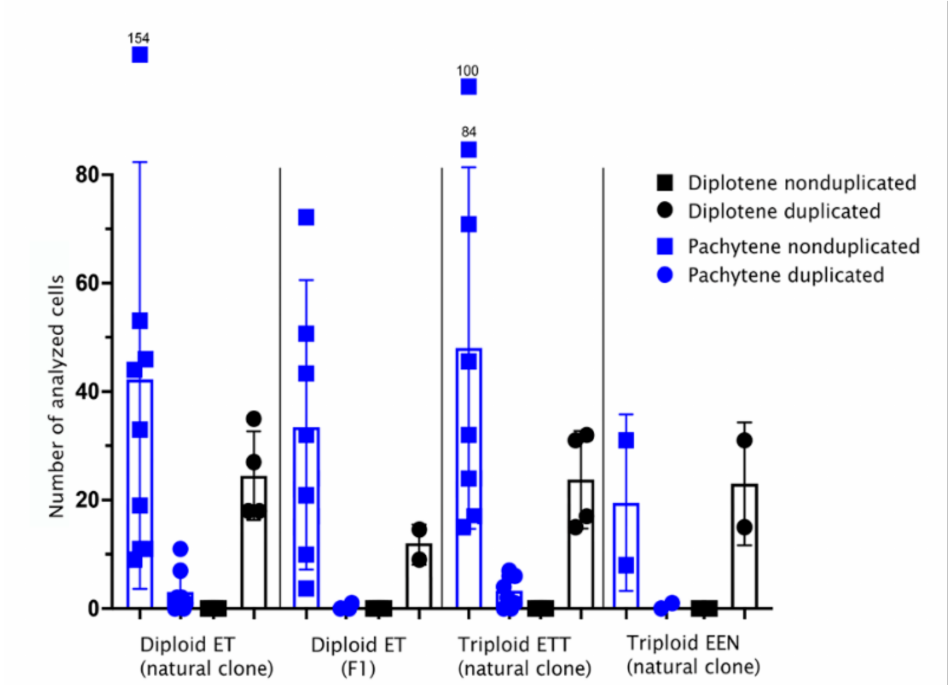
Figure 2. The number of cells with duplicated (marked as circles) and nonduplicated (marked as squares) genomes observed during pachytene and diplotene in natural diploid ET hybrids, artificial F1 diploid hybrids, and natural triploid ETT and EEN hybrids. The number of cells: mean ± standard deviation. During the pachytene stage (blue graphs), two populations of oocytes were detected in all diploid and triploid hybrid individuals. The major population of oocytes did not have a duplicated genome (oocytes with diploid and triploid genomes for diploid and triploid hybrids, correspondingly) and the minor population had a duplicated genome (oocytes with tetraploid and hexaploid genomes for diploid and triploid hybrids, respectively). During diplotene (black graphs), only cells with duplicated genomes were observed for all diploid and triploid